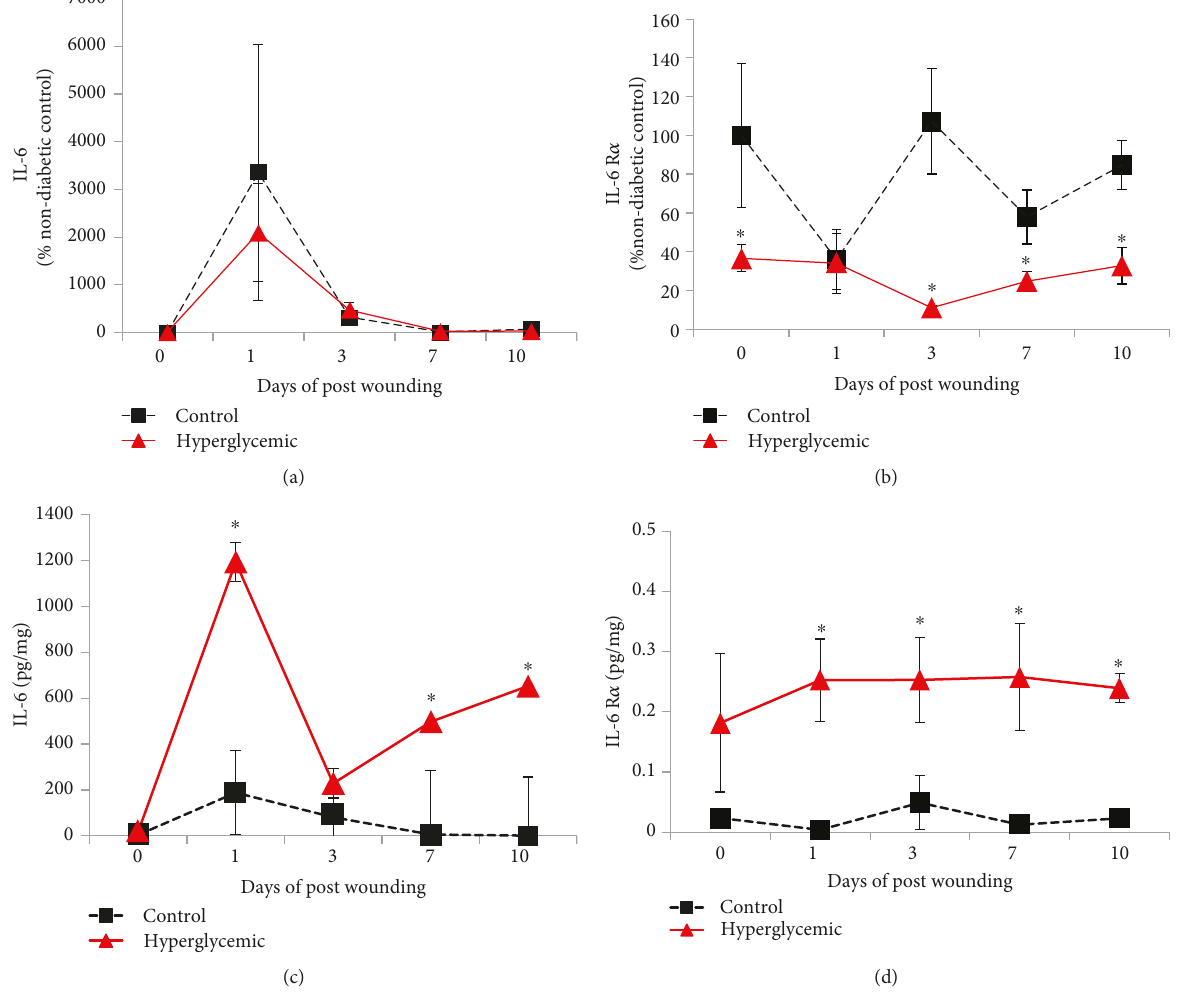
Figure 2: Hyperglycemic wounds exhibit greater IL-6 and IL-6R α protein expression. Following four weeks of hyperglycemia, hyperglycemic and age-matched euglycemic control mice were wounded with full-thickness 4 mm biopsy. Wound tissue was collected, and total mRNA and protein extract was isolated as described. (a) IL-6 and (b) IL-6R α mRNA expression was determined via qPCR and expressed as percent control (day 0 control animals). (c) IL-6 and (d) IL-6R α protein expression was determined by ELISA and normalized to total protein. Data are presented as the means ± SE ; n = 10 . ∗ p < 0 05 , signi fi cantly di ff erent from euglycemic C57BL/6 control